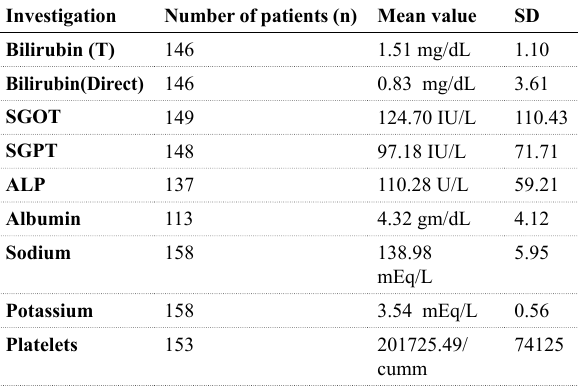
Table 1: Various laboratory findings done in the